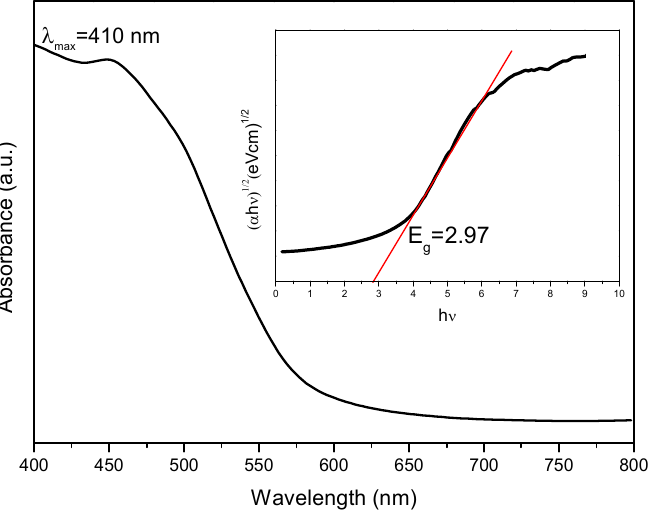
Figure 11. Absorption vs. wavelength spectrum of RF/TiO 2 dispersed in ethanol measured through UV-Vis spectrophotometer, inset shows calculated band gap of synthesised RF/TiO 2. The photodegradation of MB dye, that is, the reduction in concentration with time is recorded in Figure 12 and the recorded data is modelled using pseudo first order kinetics, shown in Figure 12a,b. The data are fitted to the first order kinetic equation (ln (C o /Ce) = kt) to evaluate the value of the rate constant by slope of plot ln(C o /Ce) vs. time (t) in minutes, where C o and Ce is the initial at t = 0 and final concentration at given time of MB concen- tration, respectively. The value of k here is the measure of photocatalytic performance, as it defines the concentration of reacting substances, that is, photogenerated reactive oxide species, therefore, a higher value of k signifies higher photocatalytic efficiency. As compared to no catalyst (k = 2.43 × 10 − 6 min − 1 ) pristine TiO 2 (k = 1.74 × 10 − 3 min − 1 ) and pristine RF (k = 6.89 × 10 − 4 min − 1 ), the rate of RF/TiO 2 was the highest (k = 1.27 × 10 − 2 min − 1 ). Clearly, the rate constant obtained for photodegradation of MB using RF/TiO 2 was the high- RF/TiO 2 gel which is photocatalytically active under visible light (410 nm) irradiation. The RF/TiO 2 material created in this study exhibits excellent photoactivity under visible light, which can further be explained by the mechanism of MB photodegrada- tion represented in Equations (1)–(8). The system activates when RF/TiO 2 absorbs light with photon energy (h ν ) and generates conduction band (CB) electron (e − ) and valence band (VB) hole (h + ) pairs upon under visible light irradiation. The holes interact with oxide species (H + or OH • ), which are oxidation agents that can mineralise a wide range of organic pollutants, ultimately producing CO 2 and H 2 O as end products. The reaction